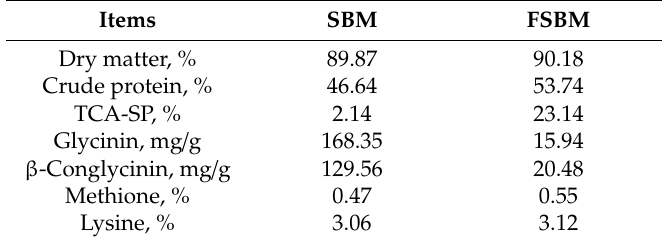
Table 1. Composition of soybean meal (SBM) and fermented soybean meal (FSBM) (air-dry basis, %).